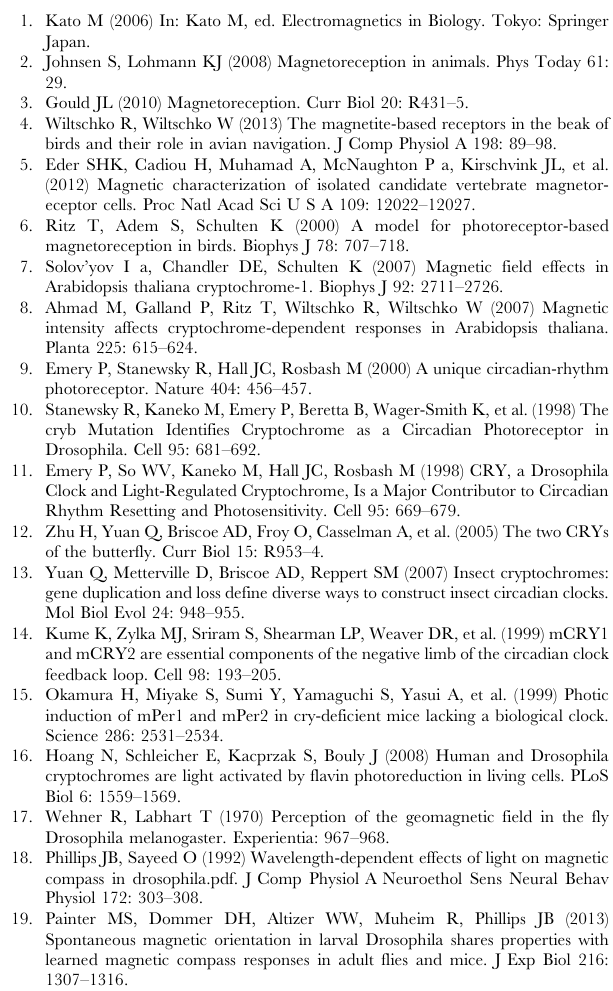
n =10 for each field strength, except n =5 for 150 m T. There are no significant differences between groups. Figure S5 No EMF-induced effects by blue or red light on SCN. (A) Representative recording of Per2::Luc bioluminescence from SCN explants under intermittent blue light. Shading indicates duration of field and light exposure. (B) Intermittent blue light exposure alone does not have any effect on the period of SCN slices. (C, D) Paired circadian periods of slices in sham and exposure conditions under blue or red intermittent light. (E-F) Period error and (G-H) relative amplitude error of SCN explants under exposure to different strength oscillating 50 Hz fields. Hatched bars =field exposure, clear bars =sham exposure, + SEM. There are no significant differences between groups, n= 12 for each condition in C-H. Figure S6 Schematic representation of the Schuderer Apparatus for flies [31]. The blue arrows represent the air flow through the chambers. Figure S7 Rhythmicity of wild-type under different intensities of constant blue light. (A) % of rhythmic CS under different blue light intensities. Heterogeneity x 2 (4) = 16.19, p = 0.0028. (B) Period